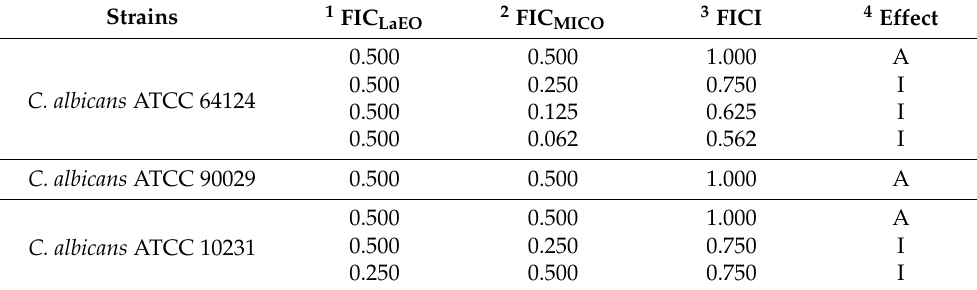
Modulatory effect of LaEO on the antifungal activity of miconazole (MICO) on Candida strains. Strains